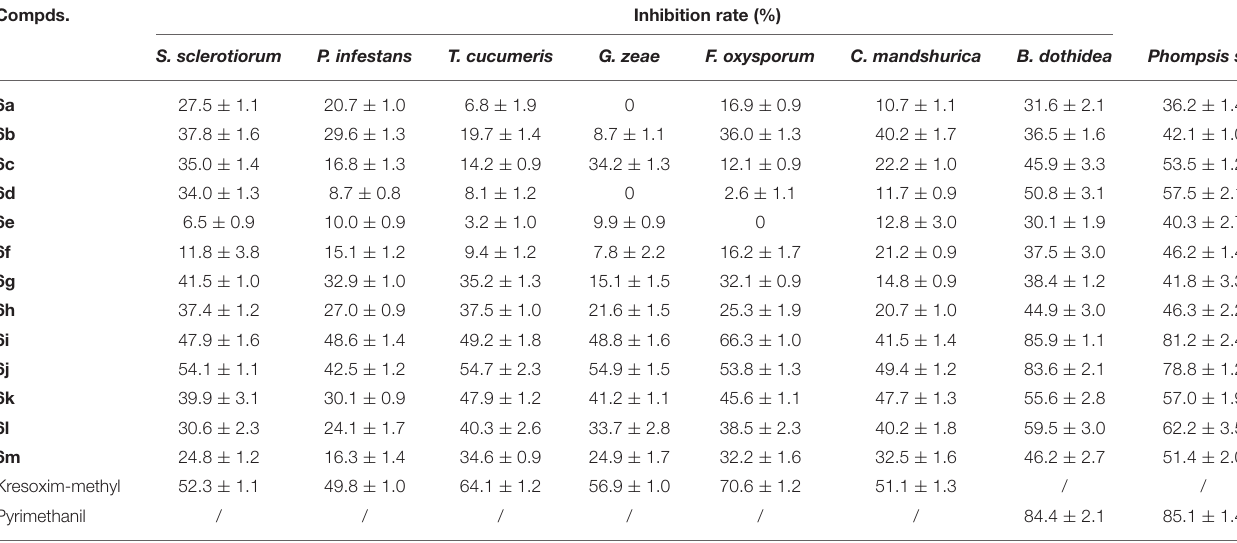
TABLE 1 | The in vitro antifungal activity of the title compounds 6a–6m at 50 µ g/mL. Compds.